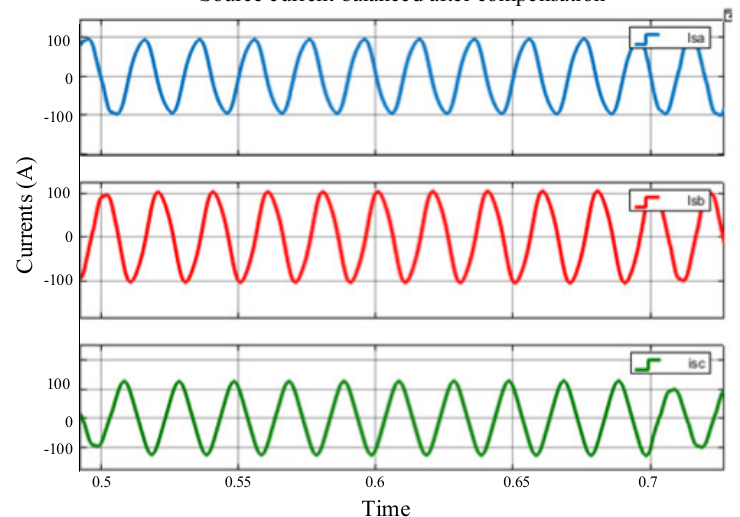
Figure 17. Load unbalanced mitigation after UPQC compensation.